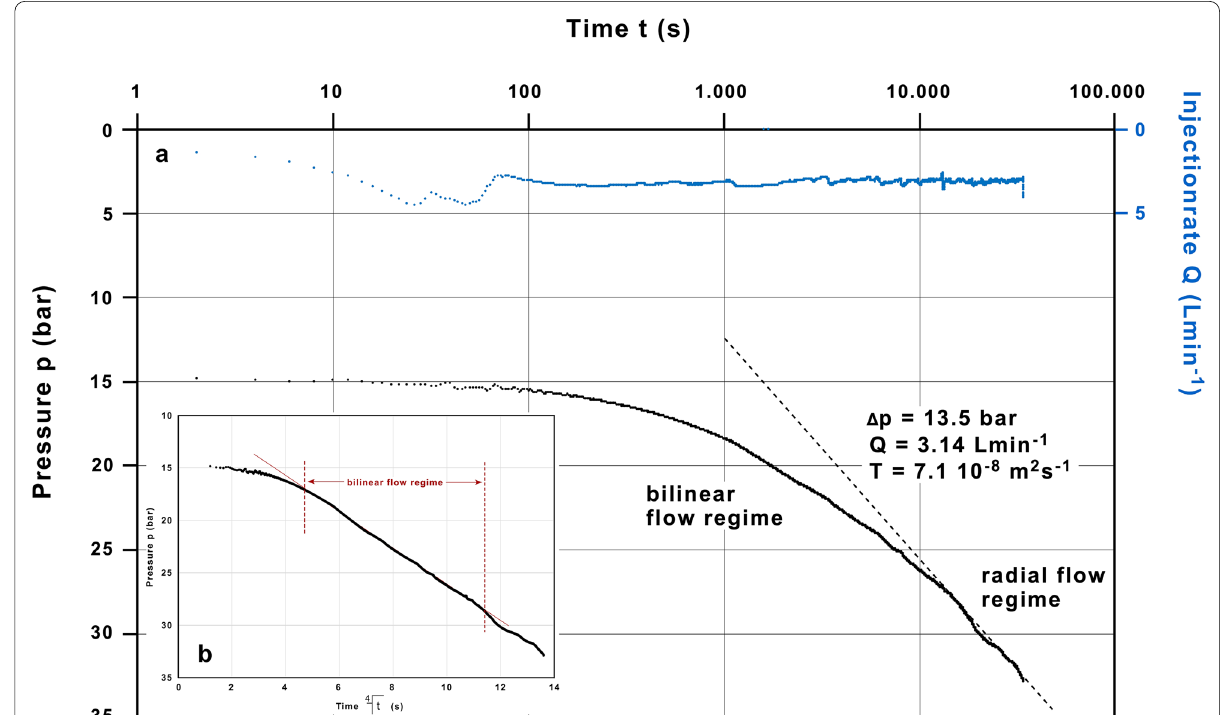
Fig. 4 Evaluation of the first sequence of the injection test with Q regime before radial flow sets